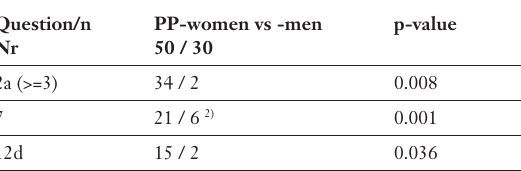
(table 3): The women scored higher on TCE- items 2a: ”parents humiliating/accusing child”, 7: ”parents, sick/unhappy, child feeling guilty”, and 12d: ”child being raped”.